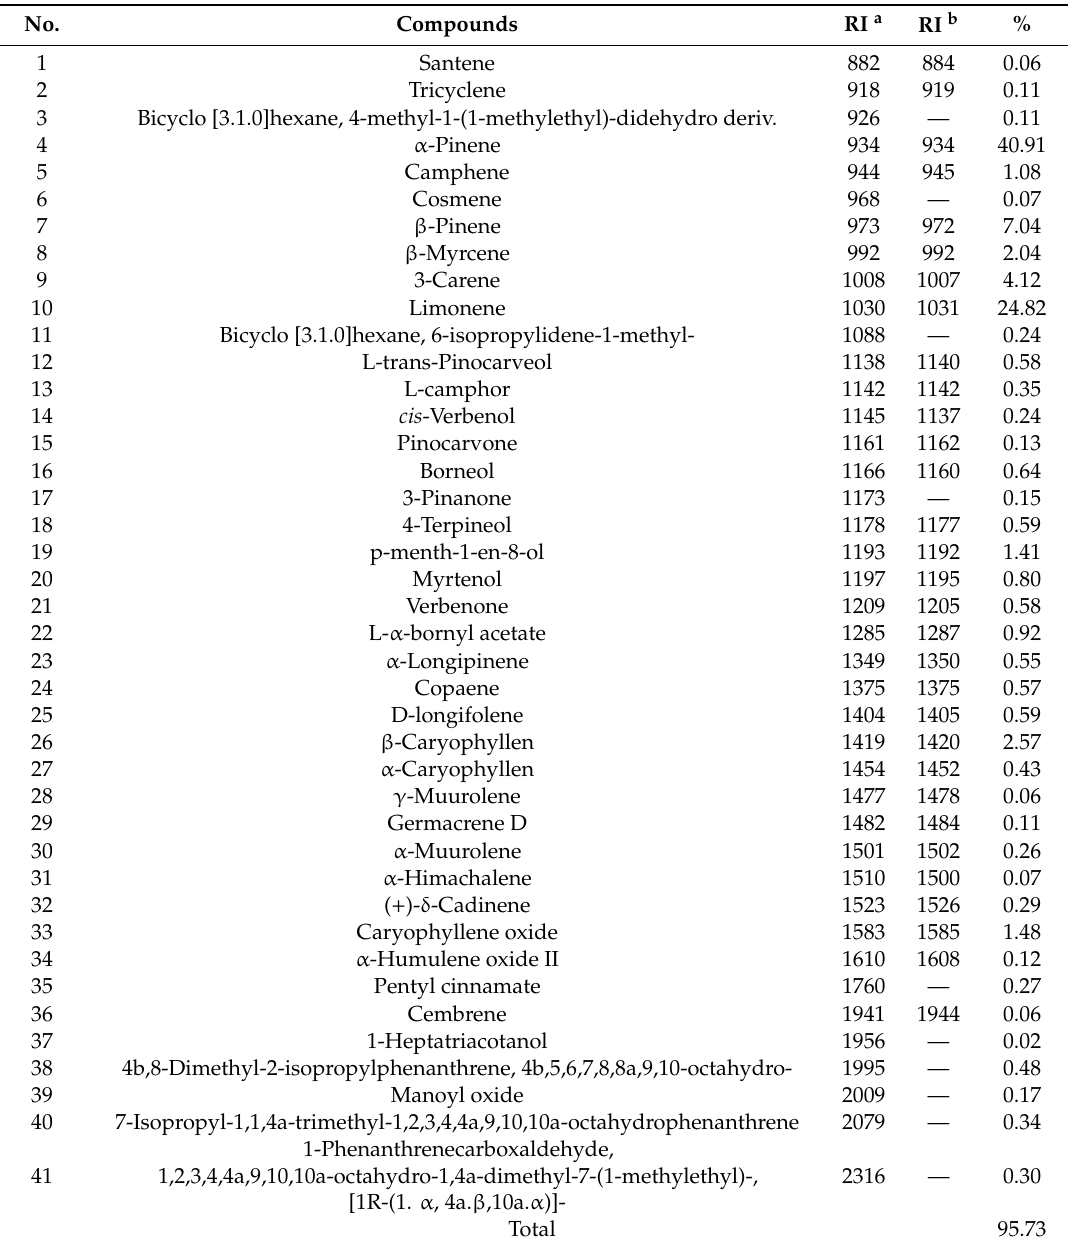
Table 1. GC-MS analysis results of PEO